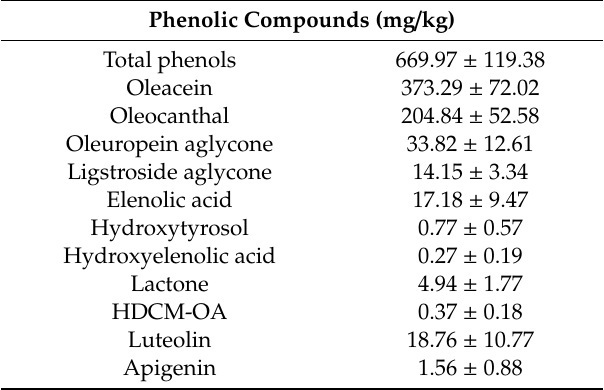
Table 3. Phenolic compound profile of olive oil from ivory-white